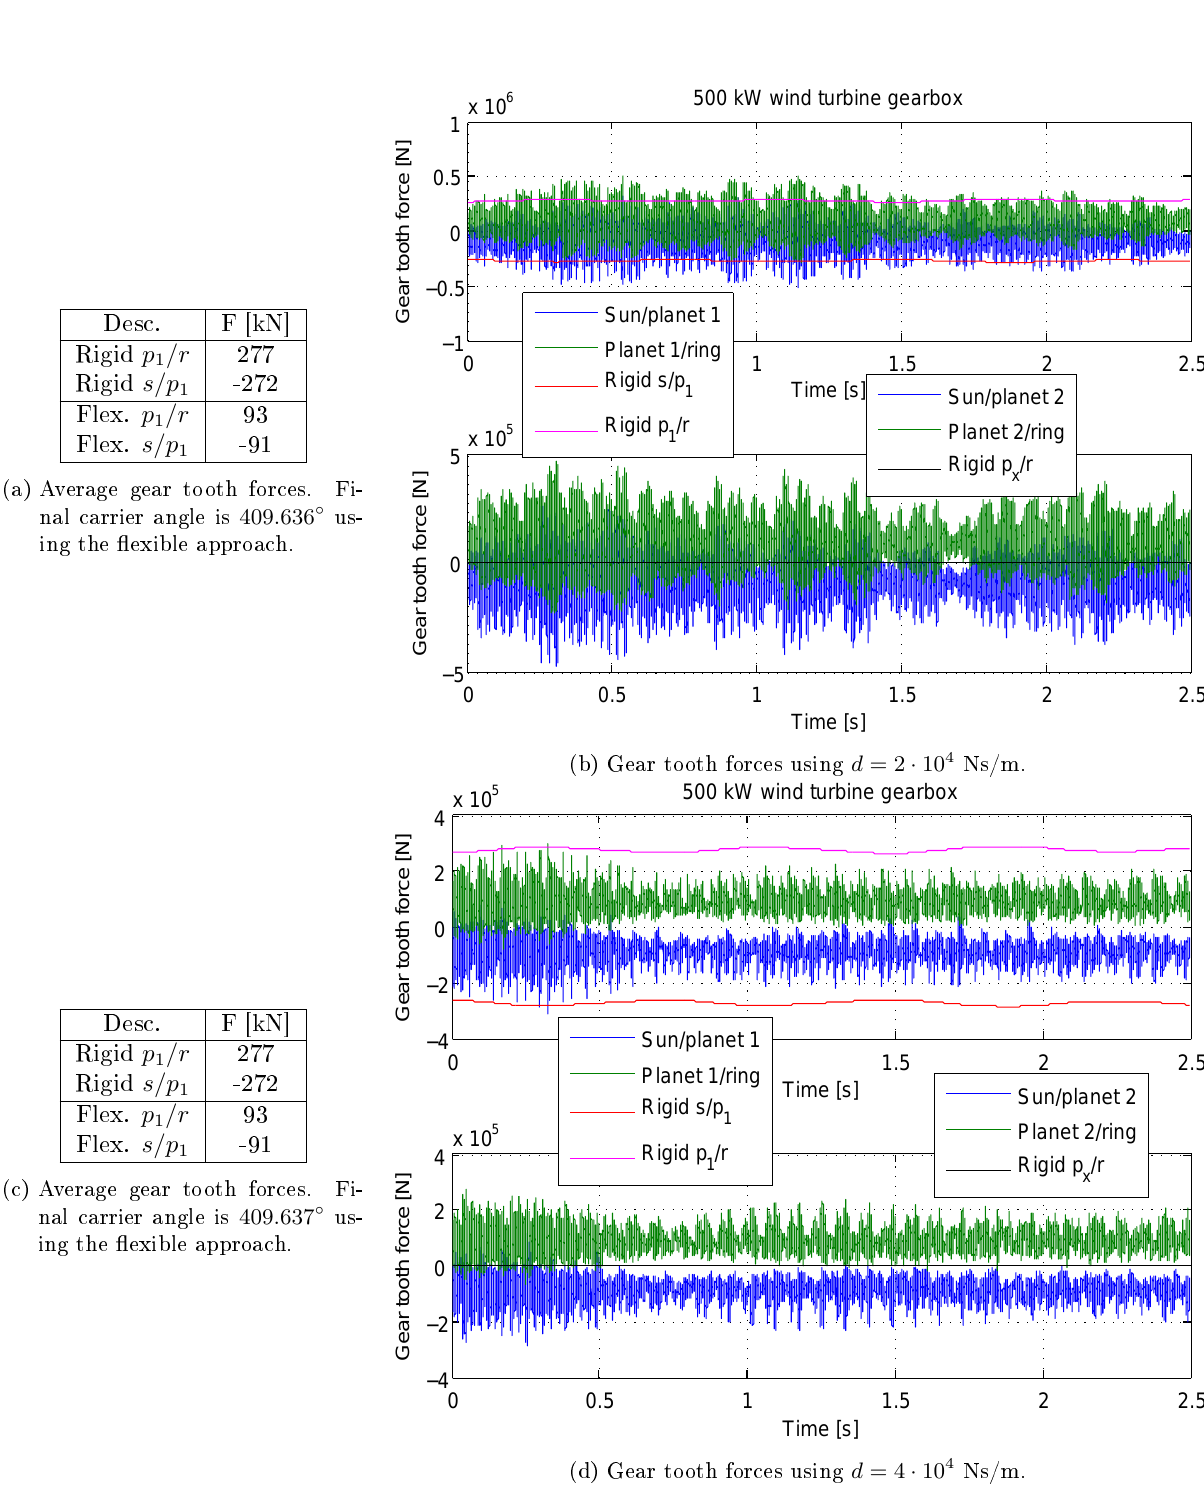
Figure 14: Gear tooth forces using rigid/(cid:29)exibly connected bodies for modelling a real planetary gearbox using pro(cid:28)le shift and realistic sti(cid:27)ness/damping parameters. Final carrier angle is 409 . 622 ◦ by using the rigid approach, meaning that the di(cid:27)erence is